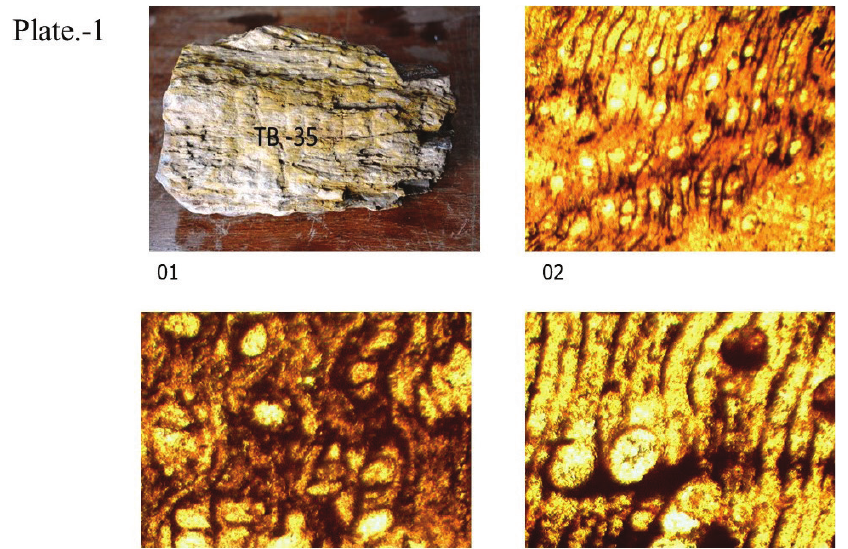
Figure 2. Atalantioxylon thanobolensis sp. nov. Plate 1-01: Macrograph of the fossil wood TB 35. Plate 1-02: Cross section showing general distribution of vessels and parenchyma (×40). Plate 1-03: Cross sec- tion showing general distribution of vessels and parenchyma. (×100). Plate 1-04: Cross section showing details of vessels and parenchyma. (×200).